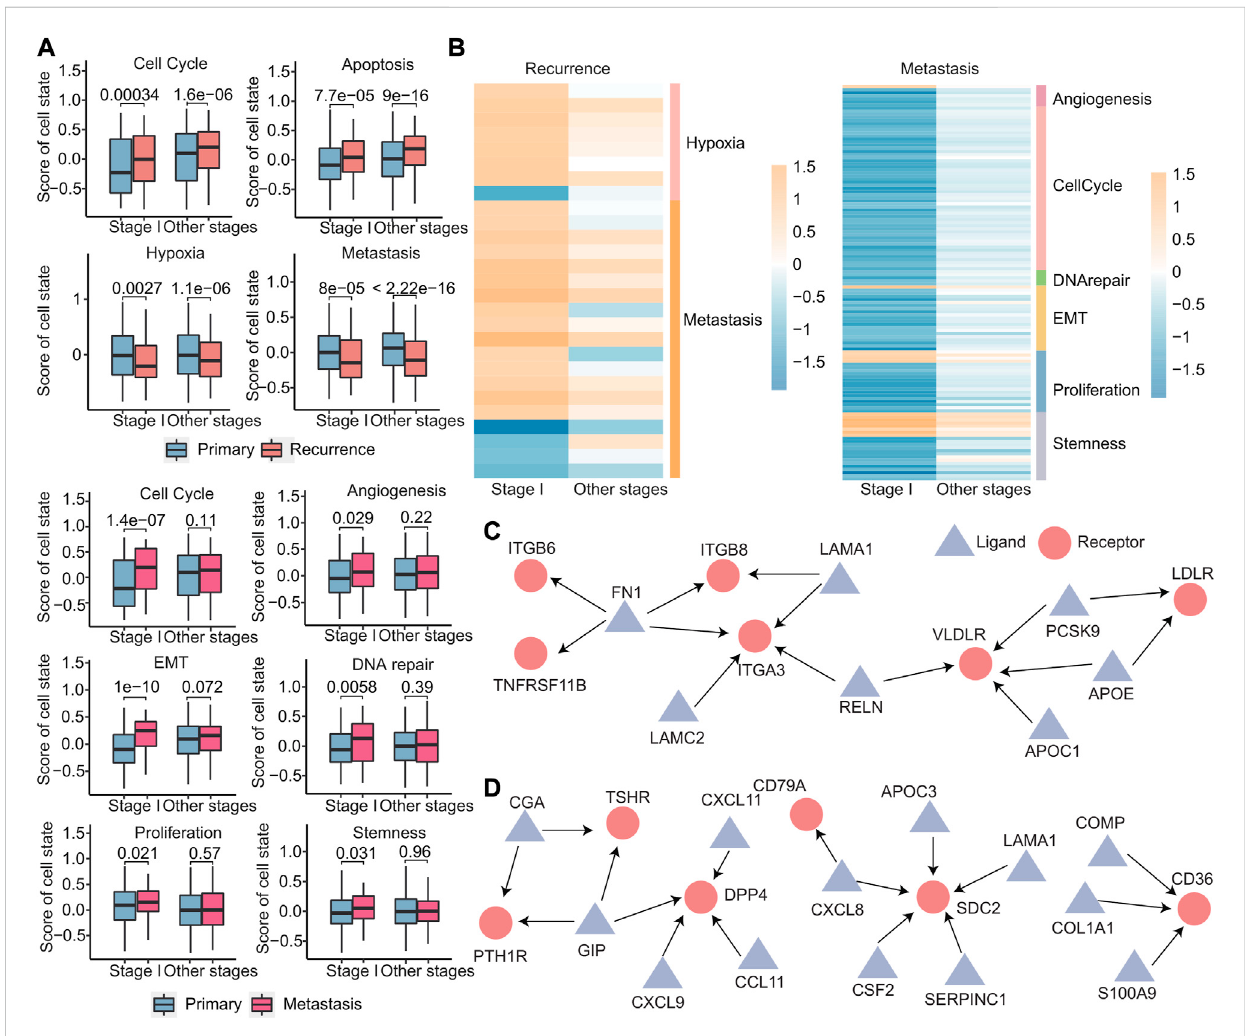
Differencesinprimary,recurrent,andmetastatictumorsatthecellularlevel. (A) Boxplotofthescorescalculatedbythecellstate-relatedgenesetfor eachsample. (B) Heatmapoflog 2 FCvaluesofgenesrelatedtocellstatuscalculatedbasedongeneexpressiondata.Thecellstatustypewasindicatedon the right. (C – D) Speci fi c ligand – receptor pair networks for stage I recurrence (C) and metastasis (D) . The triangular points are the ligands, and the round points are the